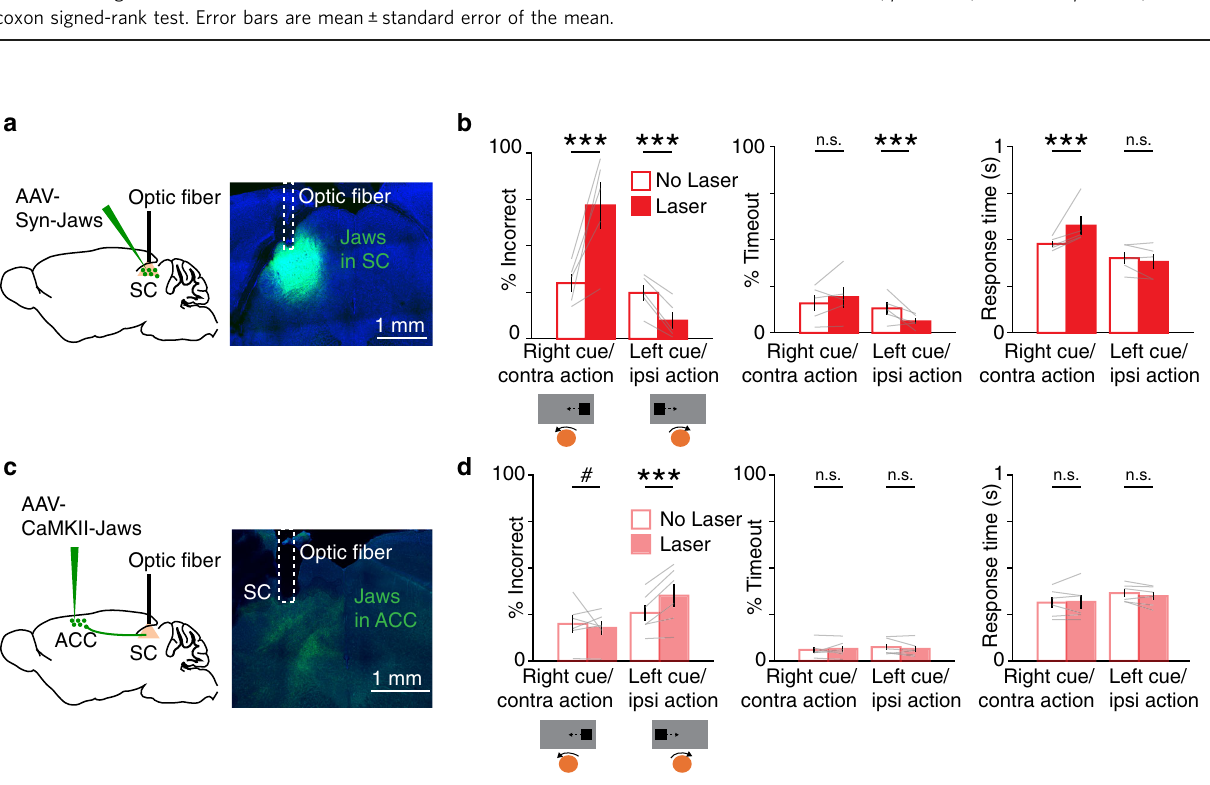
Fig. 4 Effect of SC and ACC-SC inactivation on behavioral performance. a AAV5-Syn-Jaws-GFP was injected in the SC and a fi ber optic was implanted above the injection site (green, Jaws-GFP; blue, DAPI). Similar expression and fi ber placement was observed across the 5 mice tested. b Behavioral performance for non-laser (un fi lled) and laser ( fi lled) conditions on right cue/contraversive action and left cue/ipsiversive action trials with SC inactivation ( n = 5 mice). Incorrect performance (right cue, p = 0.001; left cue, p = 0.001), timeouts (i.e., trials with incomplete responses within the allotted time; right cue, p = 0.077; left cue, p = 0.001), and response time (right cue, p = 0.001; left cue, p = 0.025) are shown. *** p < 0.005; n.s., not signi fi cant. Signi fi cance evaluated at the Bonferroni-adjusted p value of 0.025 with a two-tailed permutation test. c AAV5-CaMKII-Jaws-GFP was injected in the ACC and a fi ber optic cannula was implanted in the SC (green, Jaws-GFP; blue, DAPI). Similar expression and fi ber placement was found across the six mice tested. d Same as b , except for inactivation of ACC outputs to SC ( n = 6 mice). Incorrect performance (right cue, p = 0.061; left cue, p = 0.001), timeouts (right cue, p = 0.961; left cue, p = 0.561), and response time (right cue, p = 0.198; left cue, p = 0.092) are shown. # p = 0.061. Signi fi cance testing same as b . Error bars in all panels are standard error of the